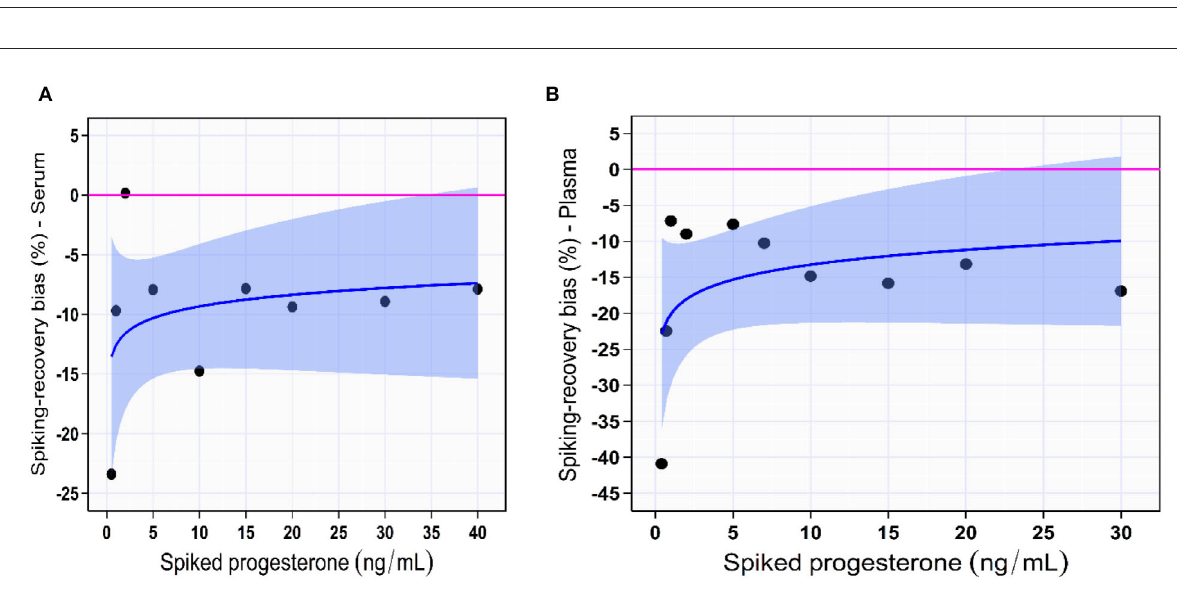
indicate the 95% confidence bands for the regression